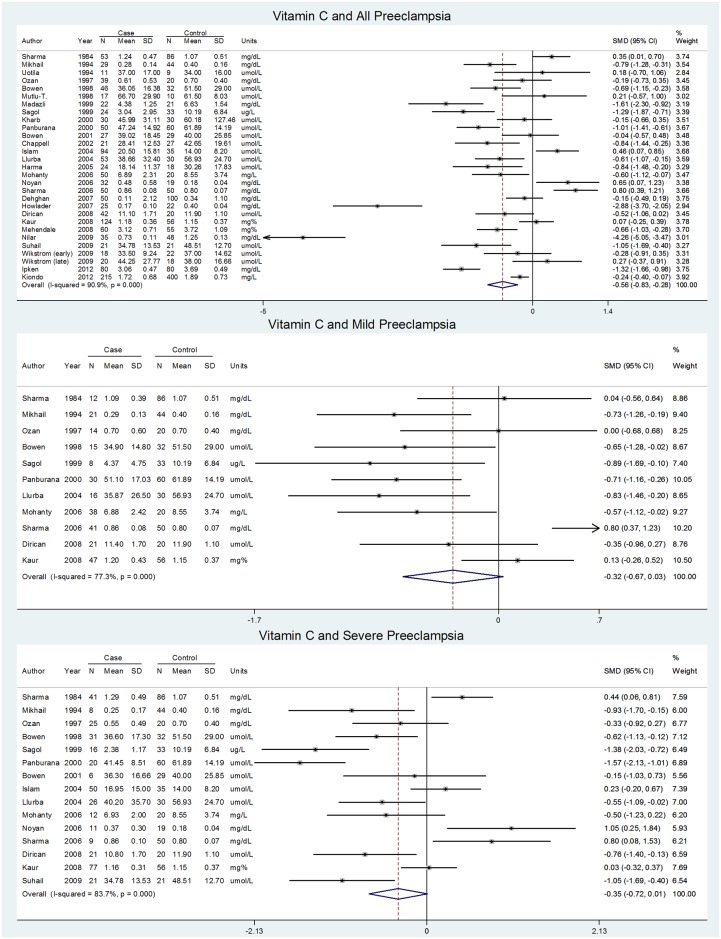
Forest plots for vitamin C and preeclampsia containing raw data.